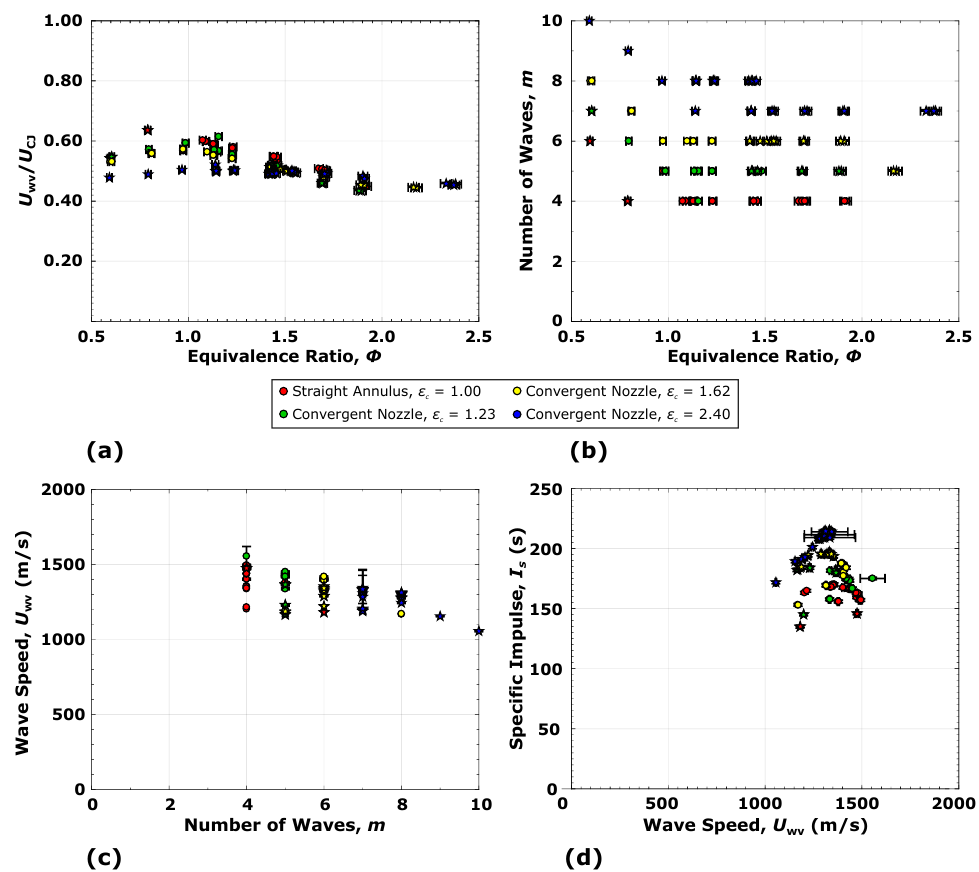
Figure 11. Summary of the detonation mode characteristics for the equivalence ratio conditions at ˙ m tot = 0.272 kg/s, depicting the ( a ) wave speed percentage of ideal and ( b ) number of waves m , as well as the wave speed sensitivity to the ( c ) number of waves and ( d ) specific impulse I s . Depending on the flow condition and convergent nozzle geometry, the engine operates in either a corotating ( • ) or counter-propagating mode ( (cid:63)